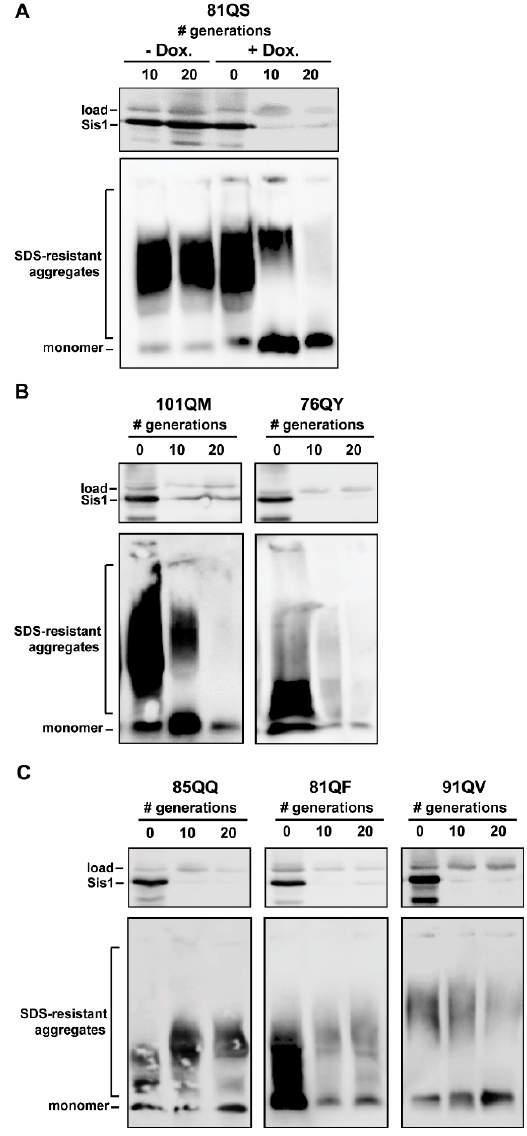
Figure 2. PolyQX synthetic prions are sensitive to Sis1 expression. Time courses of SIS1 -repression of cells bearing distinct polyQX prions were conducted in triplicate with similar results; representative results are shown. ( A – C ) Cells were harvested after the indicated number of generations of growth in the absence ( − Dox.) or presence (+Dox.) of doxycycline and pellets collected for analysis. Lysates were resolved by SDS-PAGE ( top panels ) and SDD-AGE ( bottom panels ). Sup35 and Sis1 were visualized by immunoblotting with Sup35- and Sis1-specific antibodies. A band cross-reacting with the Sis1 antibody is shown as a loading control. ( A , B ) PolyQX prion aggregates of 81QS, 101QM, and 76QY are lost following 20 generations of growth on doxycycline. ( C ) Detergent-re- sistant aggregates persist to 20 generations for 85QQ, 81QF, and 91QV.